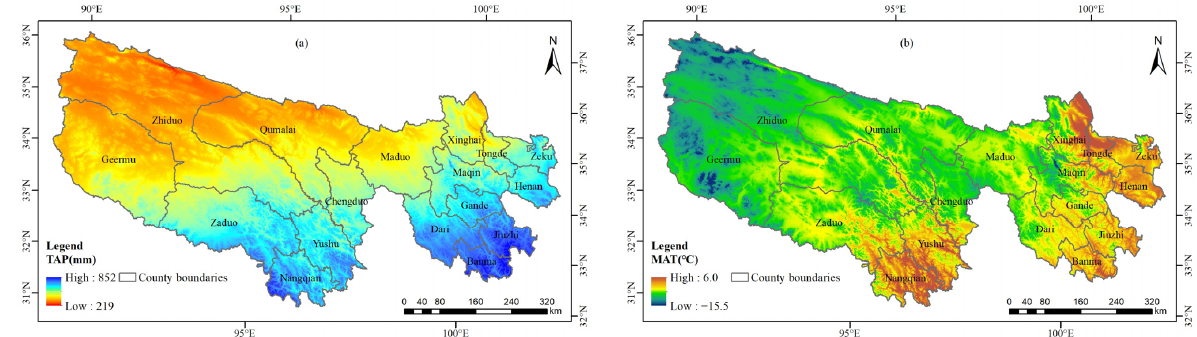
Figure 2. The spatial distribution of TRHR’s average precipitation ( a ) and temperature ( b ) from 2000 to 2019.